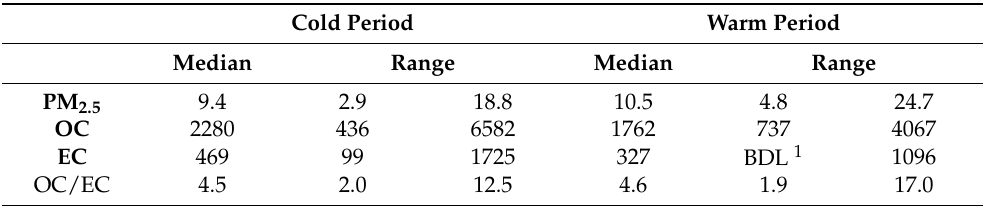
Table 1. Seasonal variability of PM 2.5 and measured chemical components’ concentrations. PM 2.5 concentrations are provided in µ g/m 3 and all components’ concentrations in ng/m 3 . Species that display statistically significant difference in concentrations between warm and cold periods (at p = 0.01) are marked in